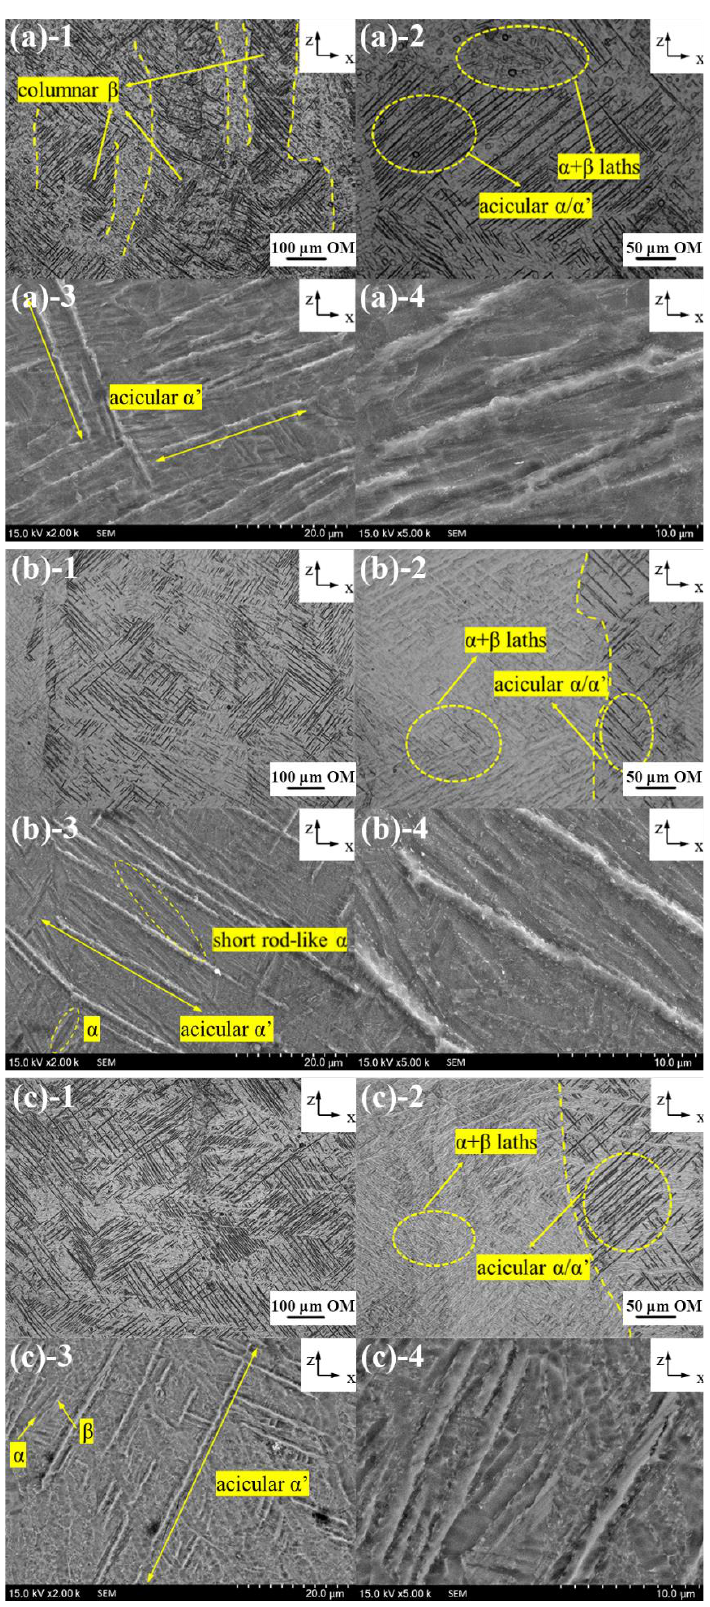
Figure 6. The microstructure of SLM TC4 under solution aging heat treatments ((1 – 4): OM-10×; OM-20×; SEM-2000×; SEM-5000×): ( a ) 930-1H-WQ + 600-8H-AC; ( b ) 960-1H-WQ + 600-2H-AC; ( c ) 960-1H-WQ + 600-8H-AC.